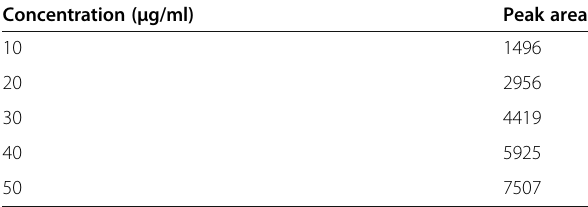
Table 4 Result of accuracy study (recovery result)